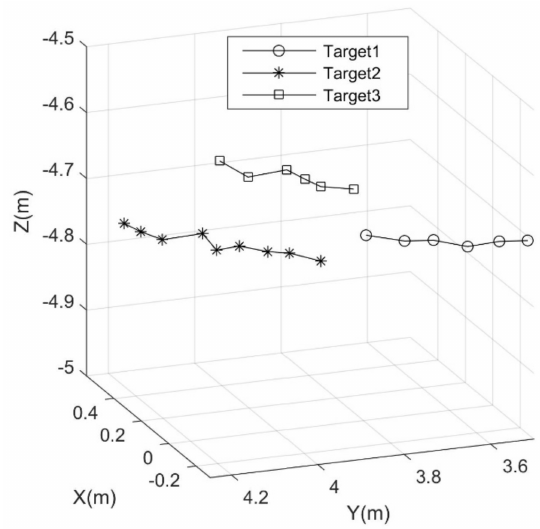
Figure 15. Target trajectories in 3D space corresponding to the 10 consecutive frames in Figure